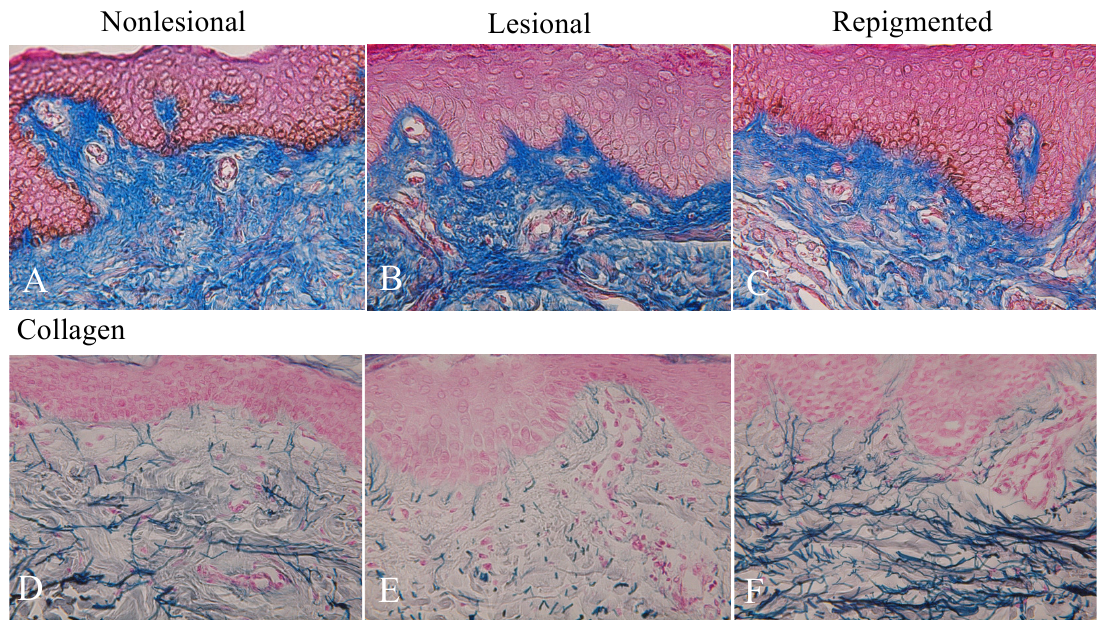
Figure 3. Azan staining reveals well-developed collagen fibers (stained light blue) in the nonlesional ( A ), lesional ( B ), and repigmented ( C ) skin in a similar density. The elastin staining reveals well- developed elastin fibers (stained blue-black) in the nonlesional skin ( D ), though in the lesional skin, elastin fibers ( E ) are greatly decreased. However, in the repigmented skin ( F ), elastin fibers are dramatically increased and exceeded compared with the level of nonlesional skin. Original magnification level, ×400.